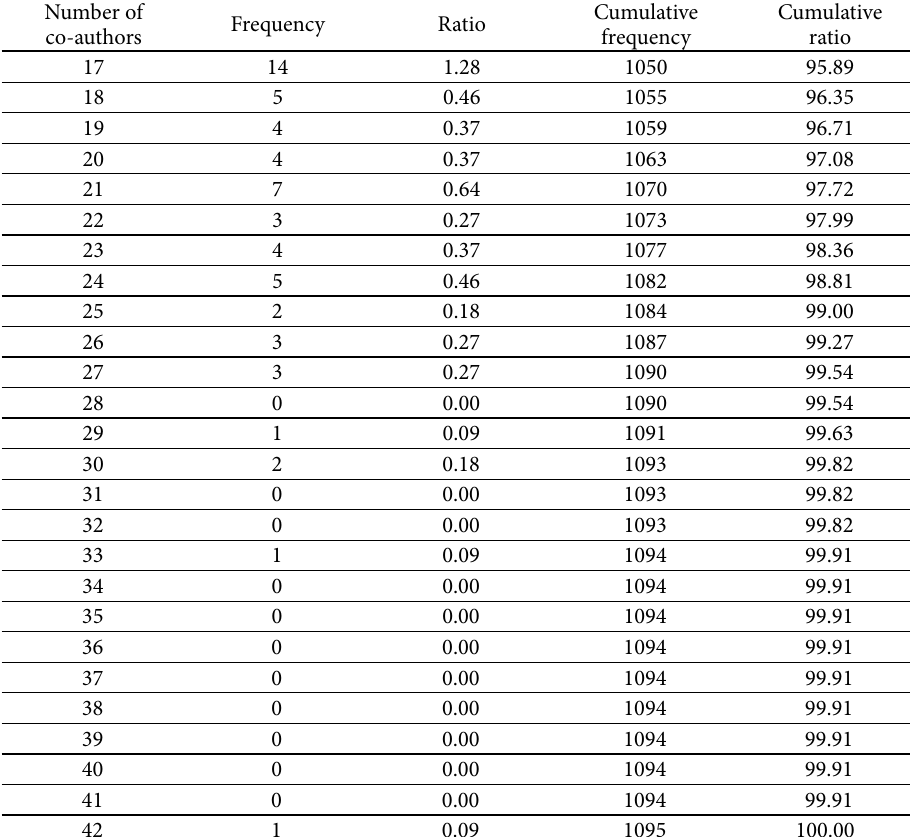
Table 4. Distribution of betweenness-based centrality in the NBI network Betweenness-based Frequency Ratio centrality